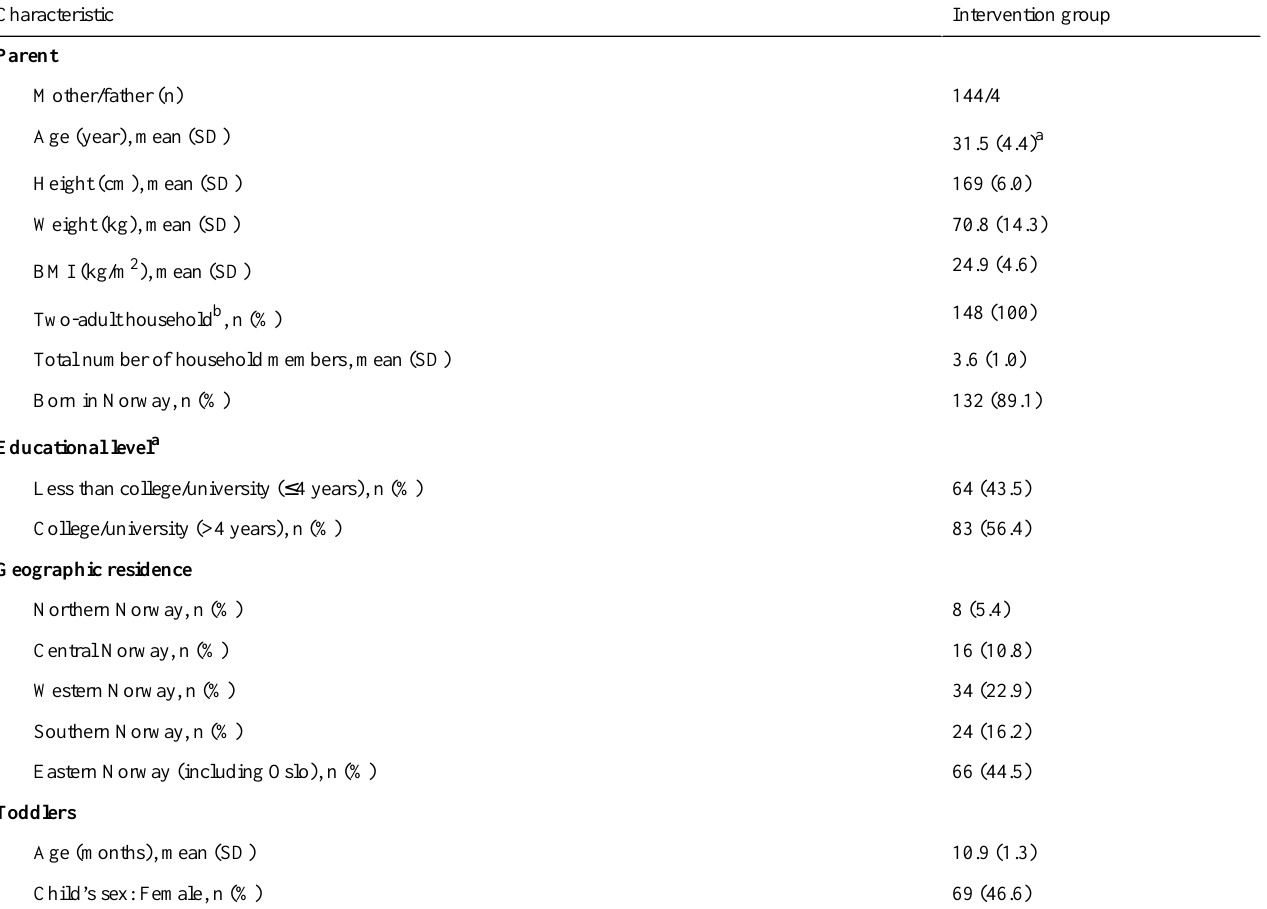
Table 1. Baseline characteristics of parents and toddlers in the intervention group (N=148).